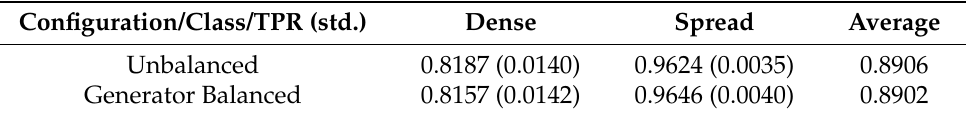
Table 11. Hierarchical tier 3: true positive rate for classification of dense vs. spread. The balancing of the dense class, using generated images, in relation to the Spread class shows slight improvement over the unbalanced configuration, and marked improvement over the four-class